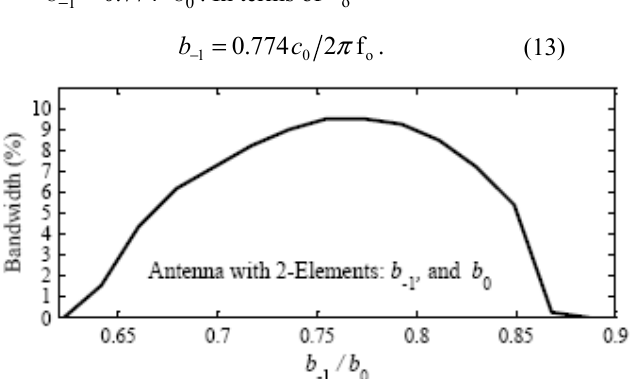
Figure 2: Variation of the bandwidth of a 2-element CCLA with b . -1